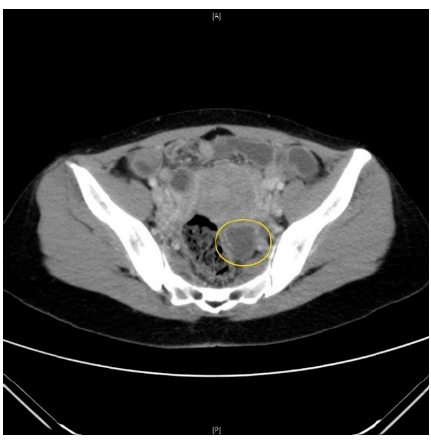
Figure 1. Computed tomography (CT) scan of the abdomen and pelvis with a left partially rim enhancing structure 2 × 2 cm suggestive of a ruptured corpus luteal cyst.